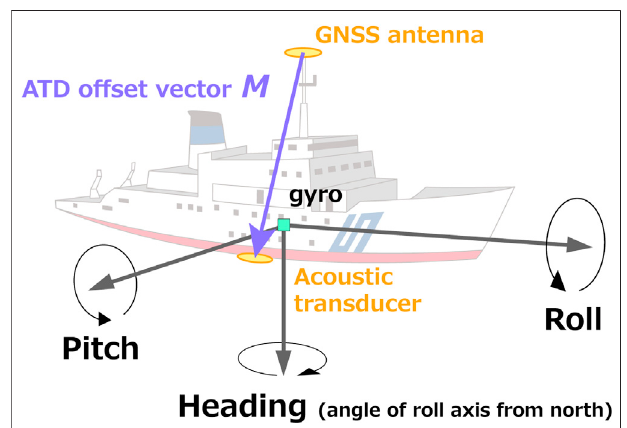
FIGURE 2 | De fi nitions of the attitude parameters and the ATD offset vector for the sea-surface platform. Heading is zero when the roll axis directs to the north. The roll and pitch axes direct forward and rightward (portside) of the vessel, respectively.